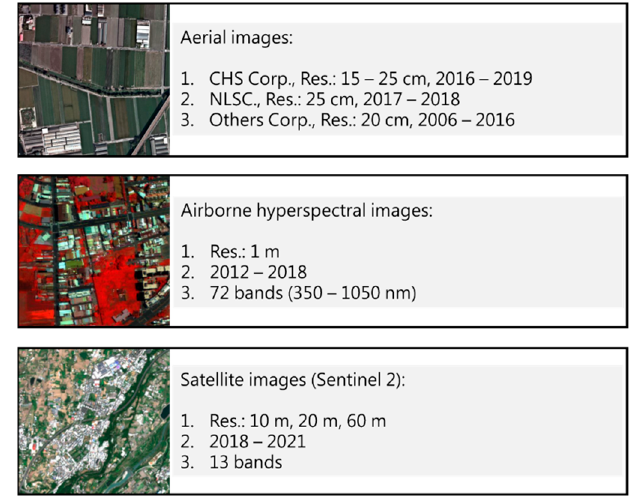
Figure 5. Specification and metadata of the source imagery.